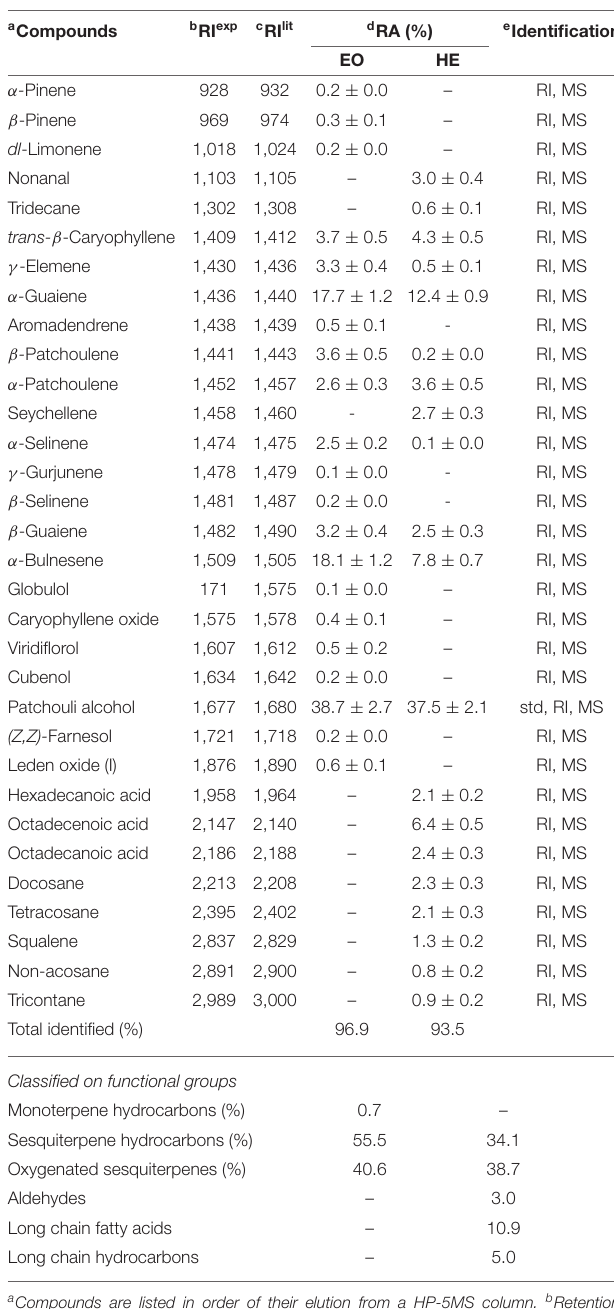
TABLE 1 | Chemical composition of volatile organic components of EO and HE of P. cablin